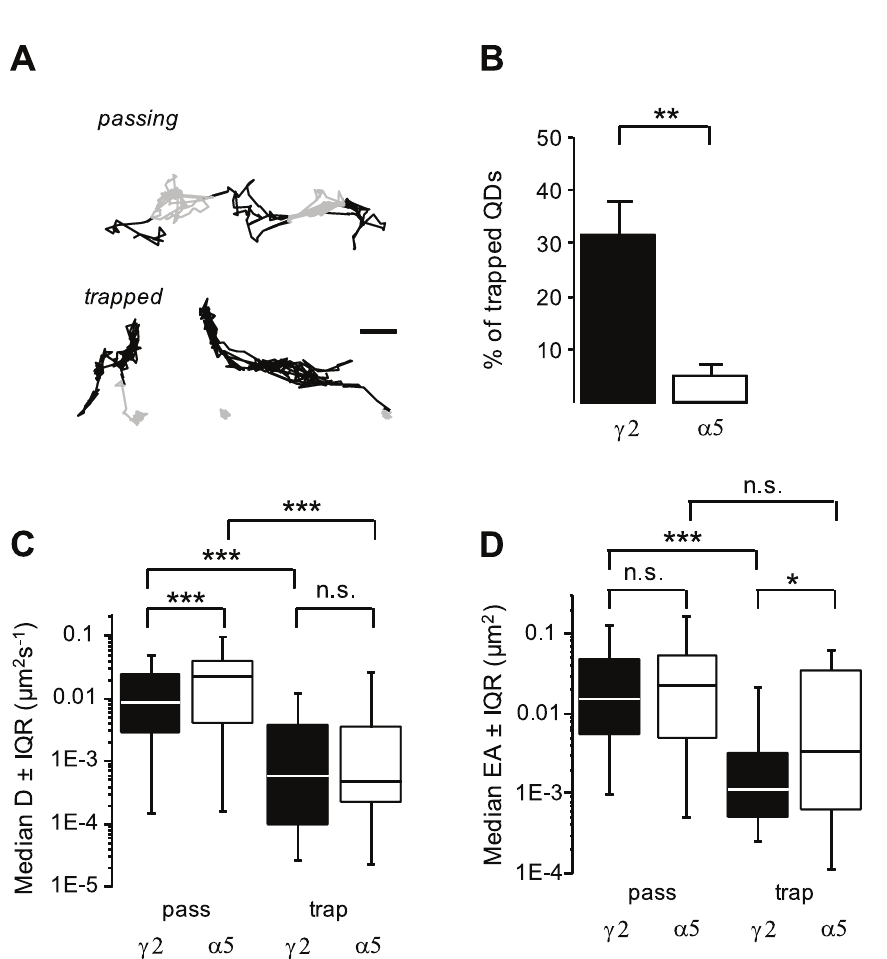
Figure 2. Segregation of passing and trapped GABA A R c 2 and a 5 at inhibitory synapses. (A) Examples of GABA A R c 2 trajectories at inhibitory synapses for passing (top) and trapped (bottom) receptors outside (black) or inside (grey) synapses. Scale, 0.5 m m. (B) Proportion (mean 6 SEM) of c 2 (black) and a 5 (white) trajectories classified as trapped at inhibitory synapses (t-test, **p , 10 2 2 ). (C) Trapped (trap) c 2 (black) and a 5 (white) have lower mobility (median D 6 25%–75% IQR) in inhibitory synapses than passing ones (KS test, ***p , 10 2 3 ). (D) Passing (pass) c 2 (black) and a 5 (white) explored a similar surface area (median EA 6 25%–75% IQR) while trapped c 2 explored a smaller surface area than a 5 (KS test, *p , 5 6 10 2 2 ; ***p , 10 2 3